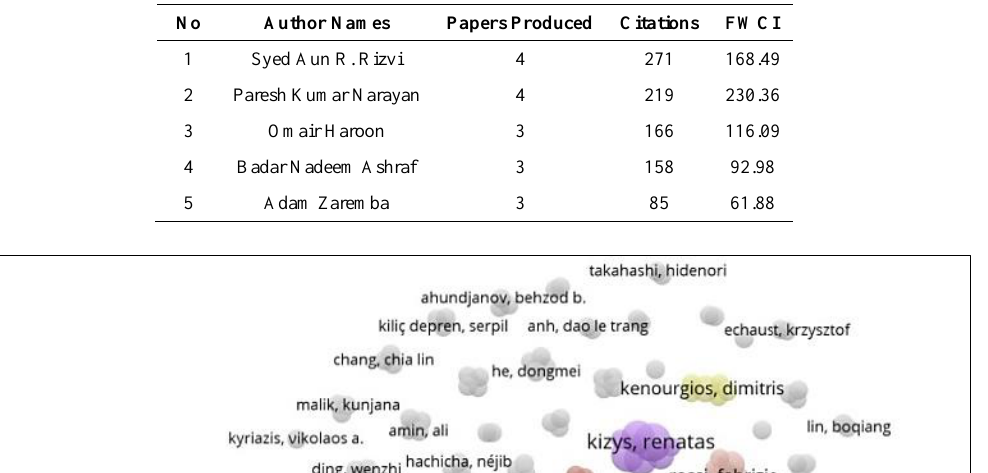
Table 7. Top 5 Authors Producing Maximum Number of Papers